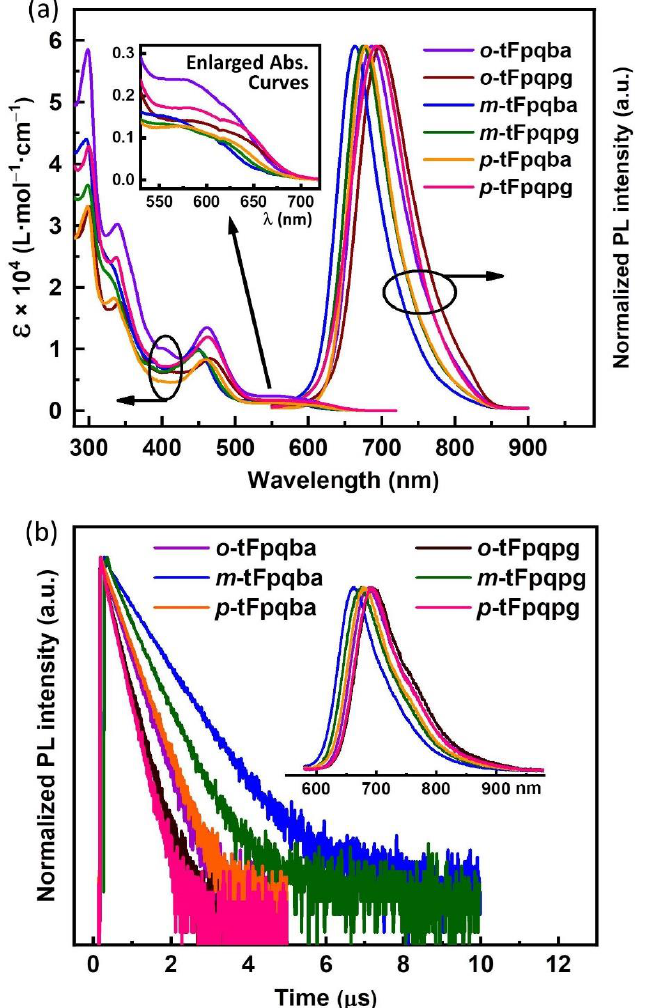
Figure 1. ( a ) UV–Vis absorption and emission spectra with 470 nm excitation in oxygen-free DCM (5 × 10 − 5 M) at 298K of all new complexes. Inset: enlarged absorption spectra in the range 550–700 nm. ( b ) Photoluminescence decay curves of the doped films based on Bebq 2 doped with each complex (5 wt%). Inset: the corresponding PL spectra of these doped films with 365 nm excitation. Table 1. Photophysical data of all new complexes. For m -tFpqba, m -tFpqpg, p -tFpqba, and p -tFpqpg, respectively, it is